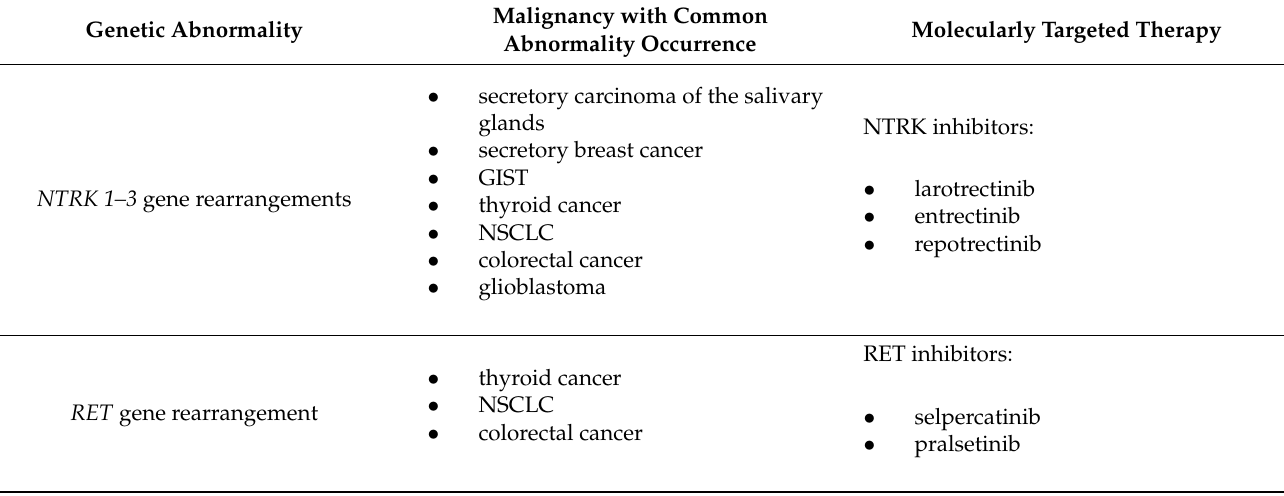
Table 2. Most important personalized therapies for adult cancer patients with defined genetic abnormalities (NSCLC, non-small cell lung cancer; GIST, gastrointestinal stromal tumor). Malignancy with Common Genetic Abnormality Abnormality